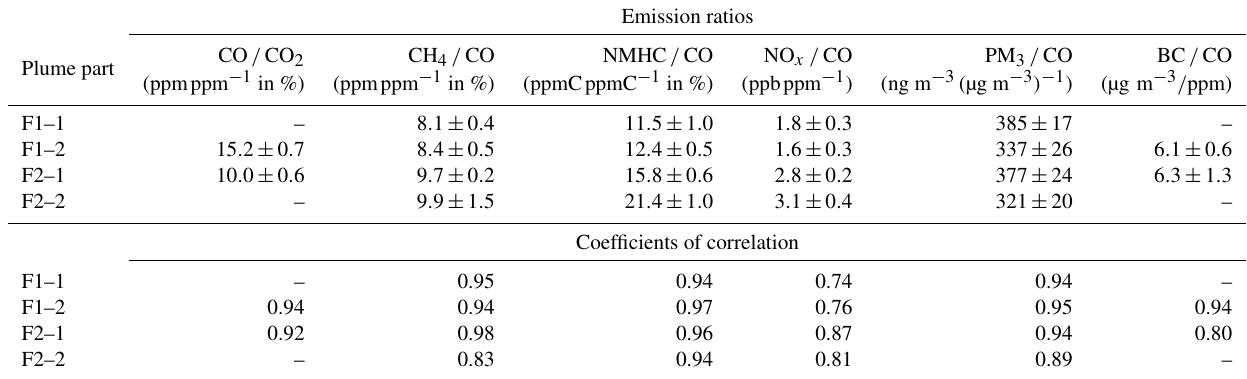
Table 5. Average emission ratios (with standard uncertainties) estimated with linear regression and corresponding coefficients of correlation ( R 2 ) for excess levels of trace gases and particles in F1 and F2 forest fire